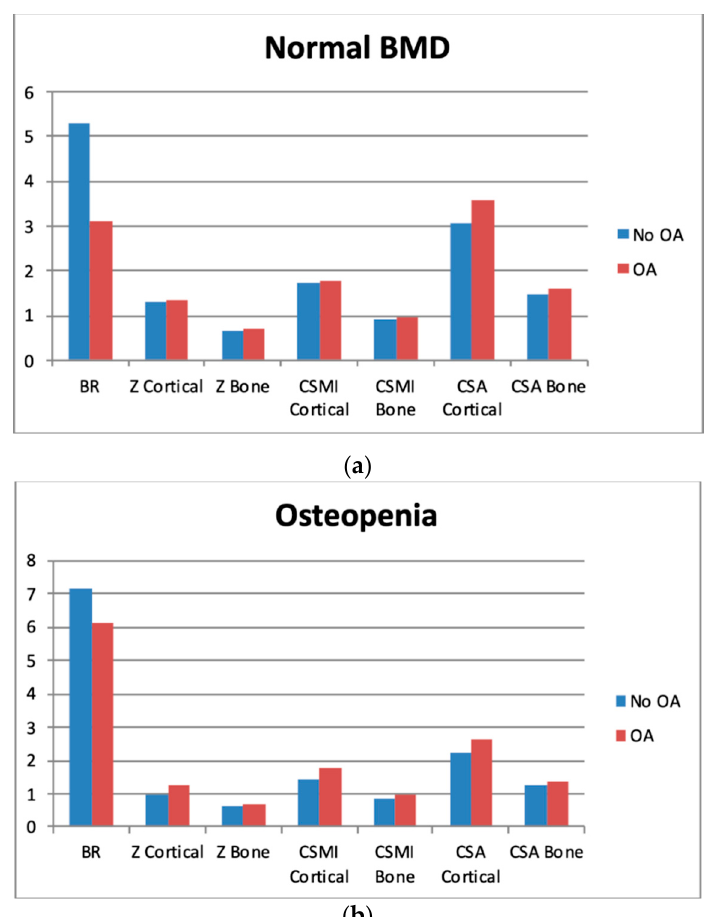
Figure 2. Differences between cross-sectional area (CSA) and biomechanical characteristics, depending on the presence of osteoarthritis (OA)—separate graphs for patients with normal BMD (2a), osteopenia (2b), and osteoporosis (2c). Please refer to “Methods”.